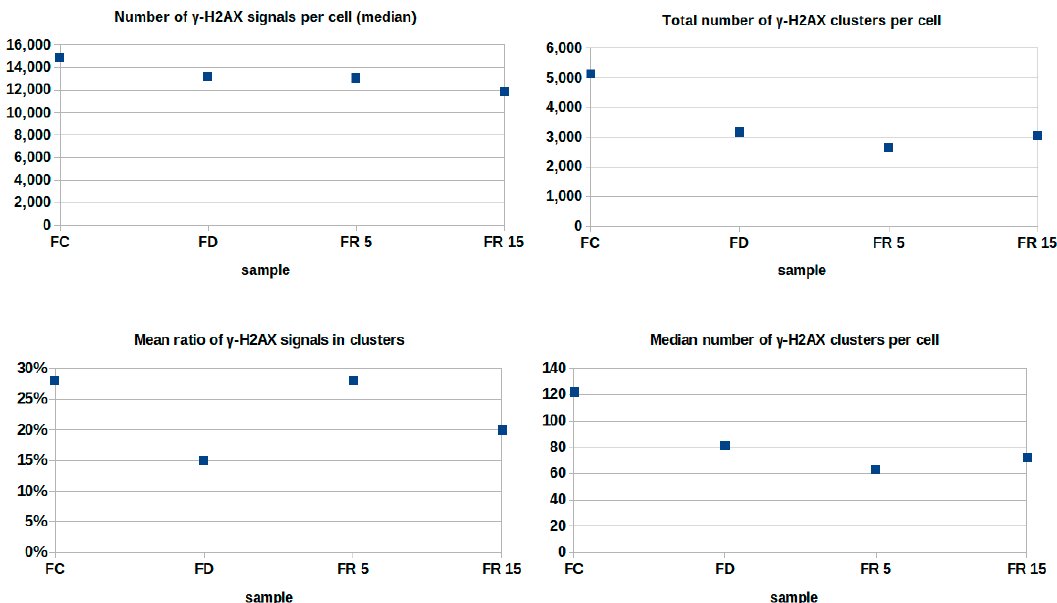
Figure 3. Quantitative evaluation (absolute numbers and ratio in %) of γ -H2AX signals for four different preparation conditions.